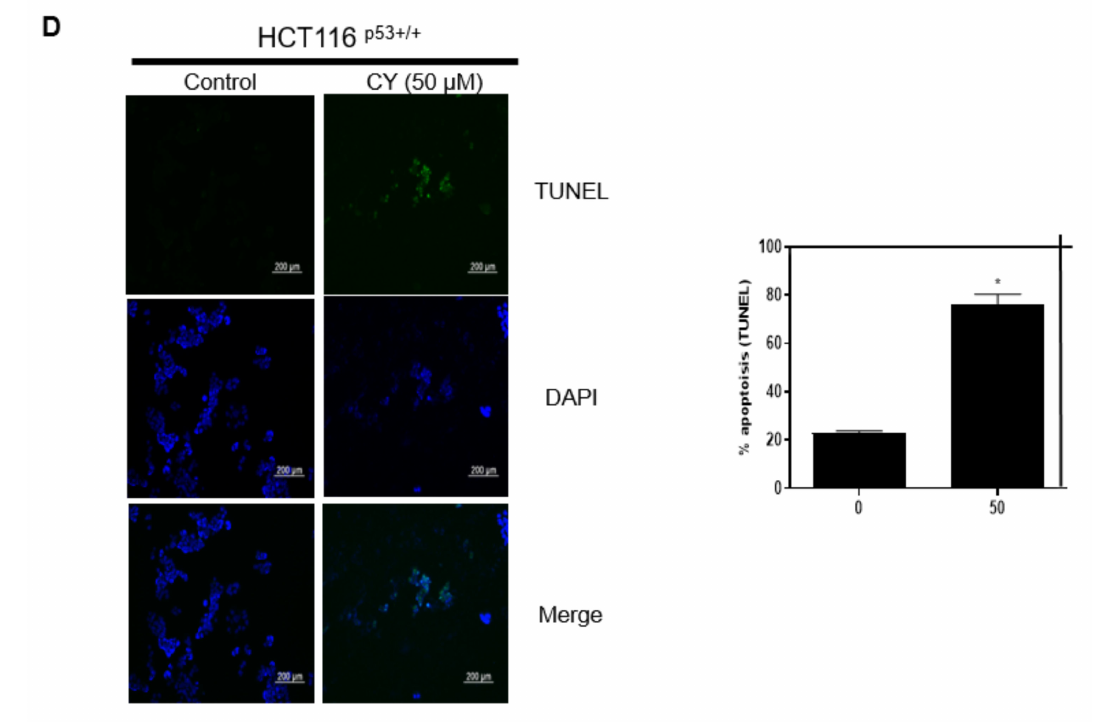
Figure 2. Inhibitory effect of CY on the p53 pathway in HCT116 p53+/+ or HCT116 p53 − / − cells. HCT116 p53+/+ or HCT116 p53 − / − were treated with 0, 25, and 50 µ M CY for 24 h. Cells were harvested from 6 wells and extracted using cell lysis buffer. ( A , C ) Protein levels of p53, caspase 3, Cleaved- caspase 3, Pro-PARP and β -actin were detected by Western blotting in HCT116 p53+/+ or HCT116 p53 − / − cells. ( B ) The relative mRNA expression level of p53 was confirmed by reverse transcription quantitative polymerase chain reaction (qRT-PCR). mRNA expression levels were normalized to glyceraldehyde 3-phosphate dehydrogenase (GAPDH). ( D ) TUNEL assay. Relative apoptosis is displayed in a bar graph with comparison to the control group. Ratio of each protein was determined by Image J. * p < 0.05. ** p <